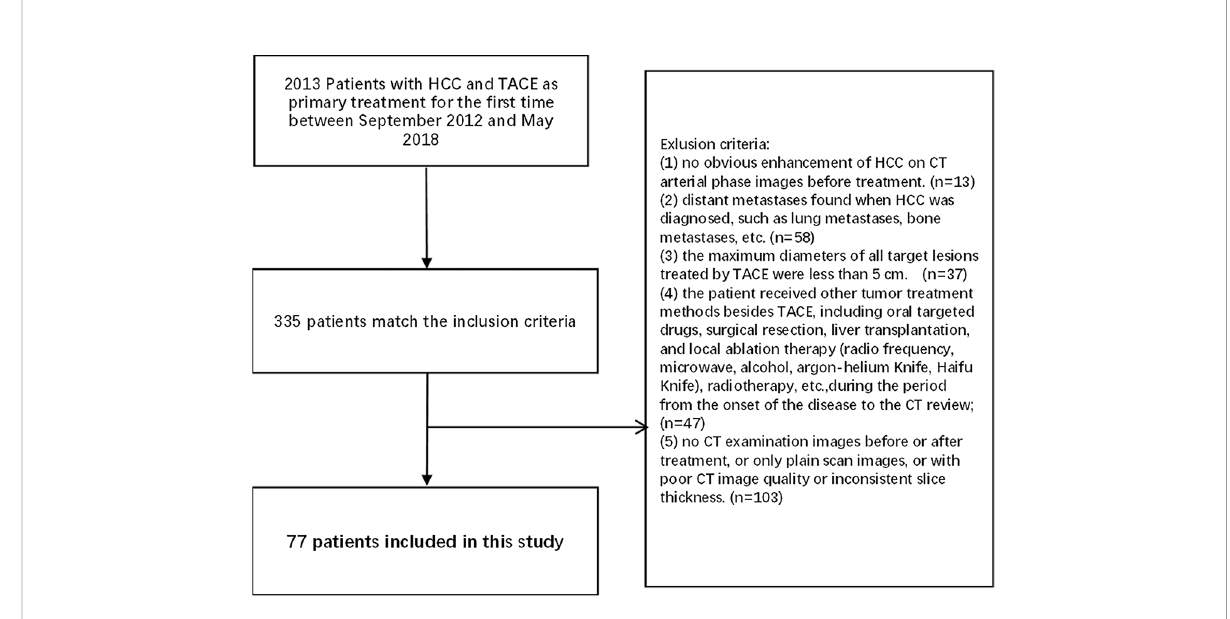
FIGURE 1 Flowchart of inclusion and exclusion criteria of our